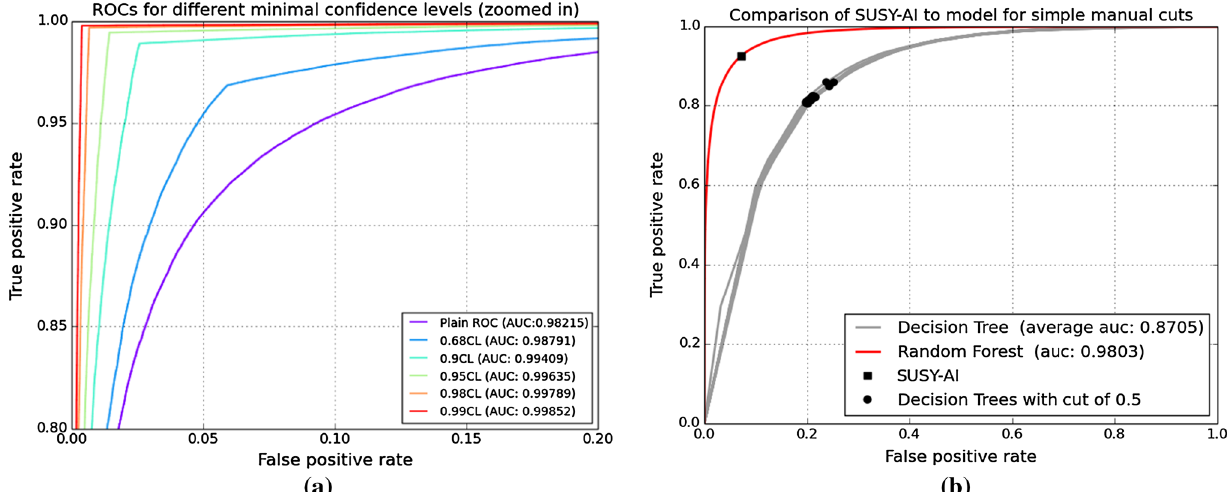
dataset. The square marker indicates the location of SUSY-AI perfor- mance without a cut on CL, while discs denote different decision